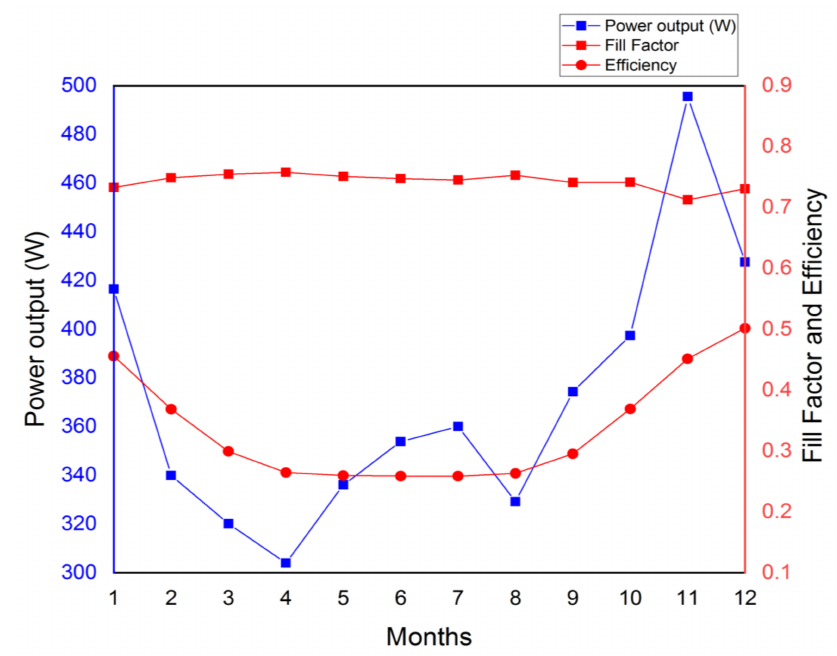
Figure 6. Power, efficiency, and FF at variable optimal tilt angles, by